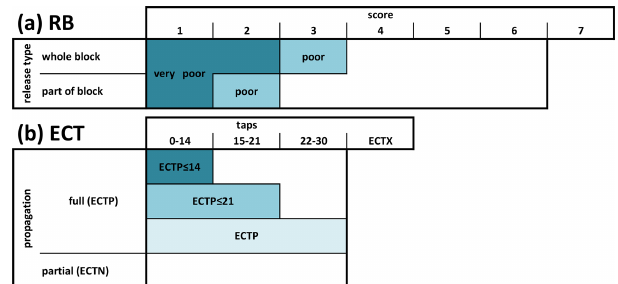
Figure 3. Classification of stability tests: (a) Rutschblock (RB) and (b) extended column test (ECT). The RB classification (RB.class) considers the score (seven loading steps) and the release type (whole block and part of block including release type edge only). Similarly, ECTs are classified combining the number of taps to initiate a frac- ture (30 loading steps) and the propagation propensity (full propa- gation: ECTP; partial or no propagation: ECTN). RB score 7 and ECTX indicate that no failure could be initiated following